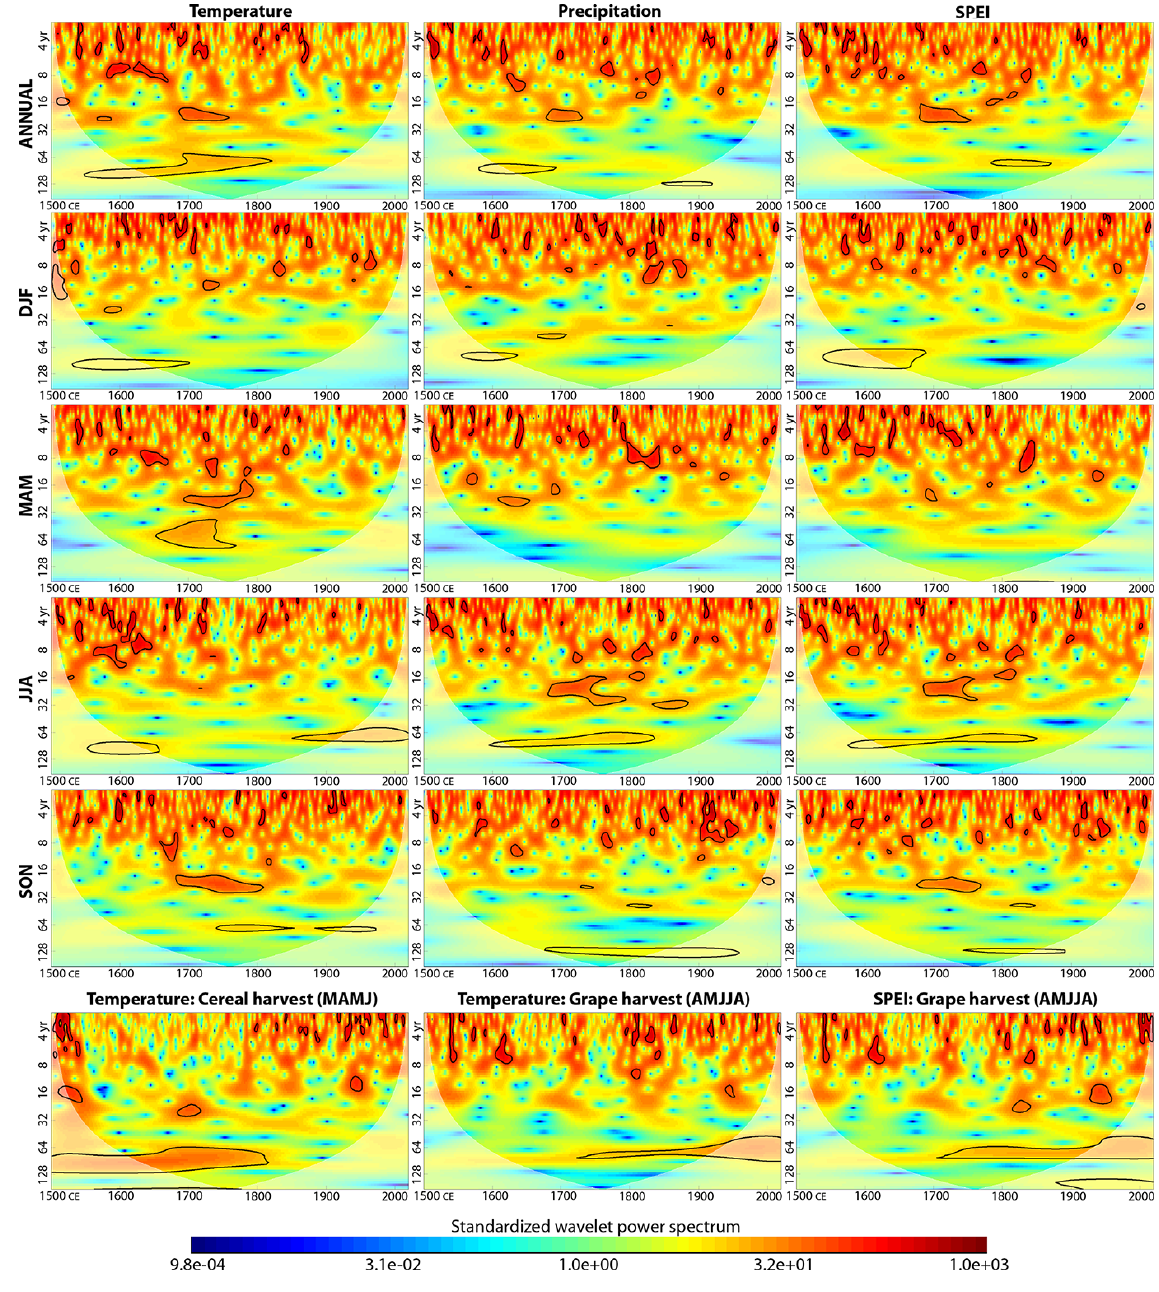
Figure 9. Standardized wavelet power spectra for temperature, precipitation, and SPEI in the Czech Lands for the 1501–2020 period. Statistical significance is highlighted at the 95% level (black line); series preprocessed by removing the GHGRF-correlated trend